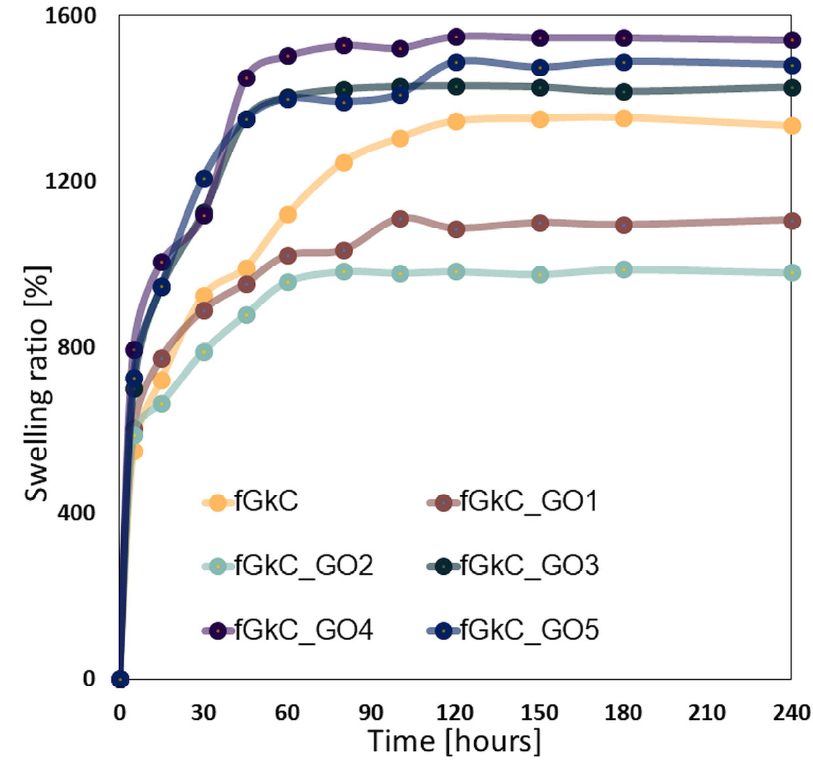
Figure 5. The swelling profile of the 6 formulations based on fish gelatin and k-carrageenan reinforced with graphene oxide .